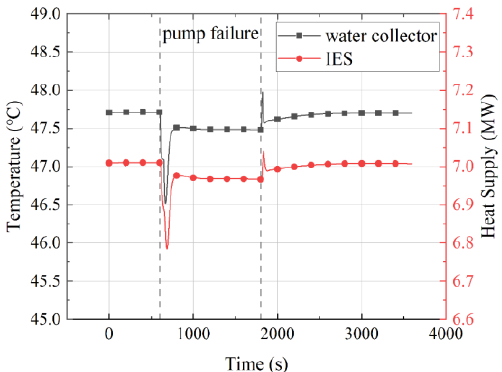
Figure 8. Heat subnet response of the IES with the AA-CAES method.